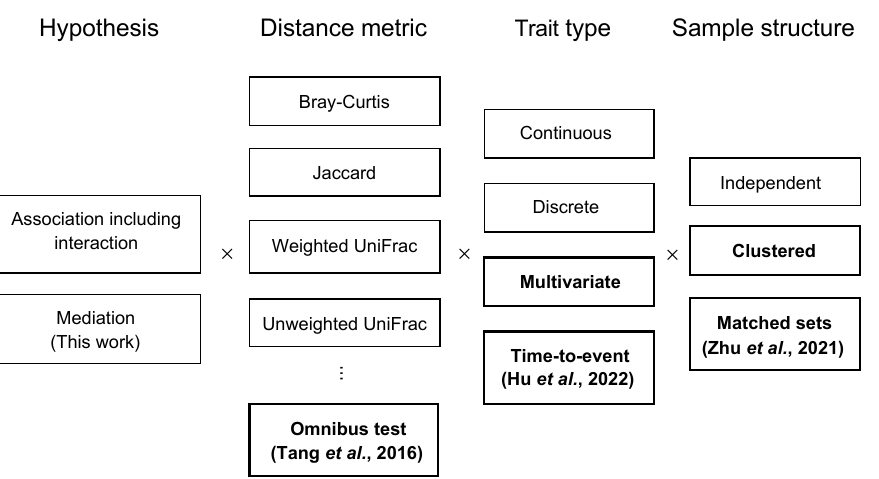
Figure 2. Analyses supported by permanovaFL. Analysis types without a citation were introduced in the original LDM paper [4]. “Clustered” refers to analyses of clustered data where traits of interest vary by cluster or vary both by and within clusters (some analyses may require special structure or additional assumptions). “Matched sets” is a special type of clustered data in which all traits of interest vary within sets. The boxes in bold are key advantages of PERMANOVA-med over MedTest and